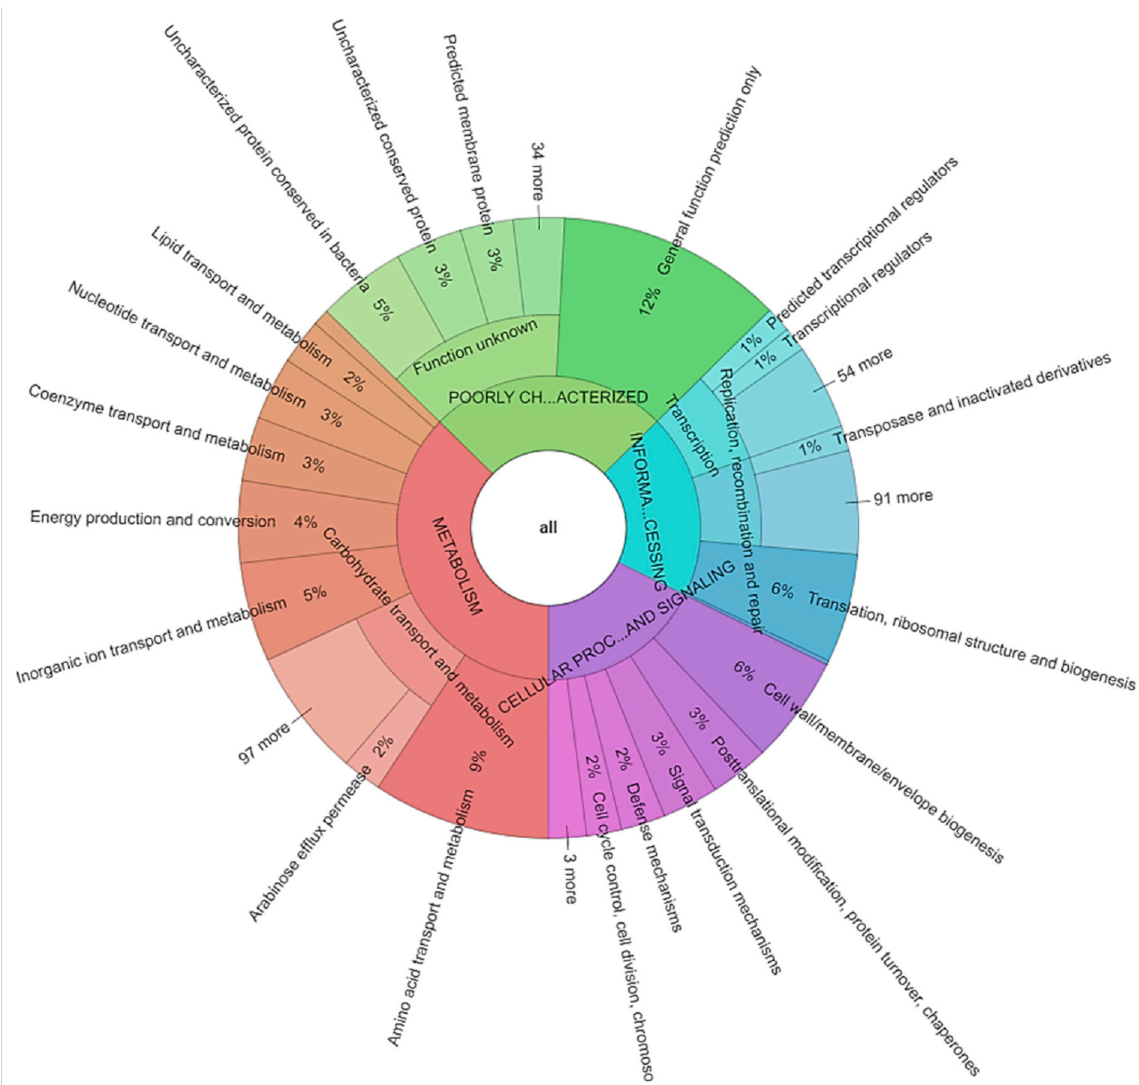
Figure 6. A snapshot of a Krona hierarchical data circle graph showing COG distribution in the complete sequence of L. hilgardii FLUB. A multi-layered interactive version with zoom and four-step depth adjustment is available via link or in the Supplementary Materials, as well as graphs for the individual replicons or